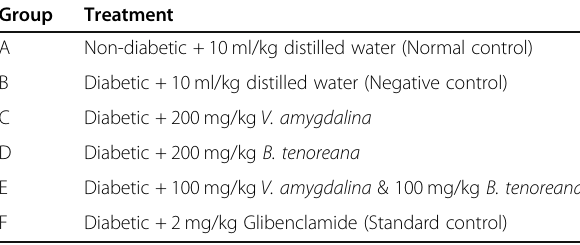
Table 1 Showing the treatment regimen for various groups Group